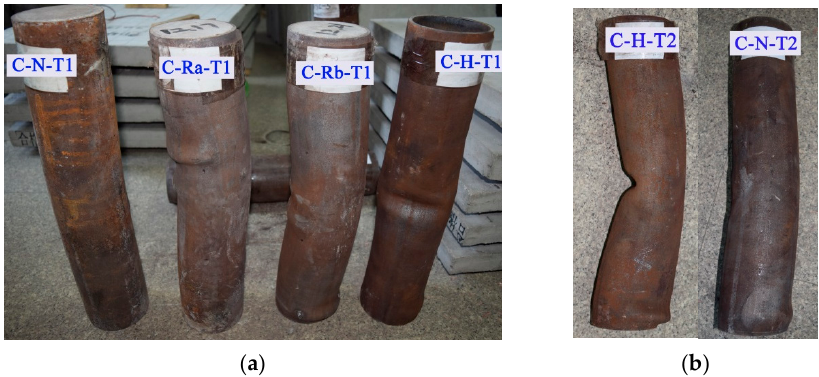
Figure 10. Failure modes of the specimens. ( a ) The wall thickness of steel tube is 4 mm; ( b ) The wall thickness of steel tube is 5 mm.